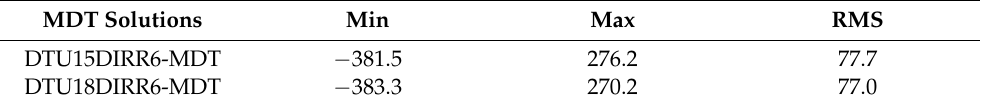
Figure 7. The MDTs of the ( a ) DTU15DIRR6-MDT and ( b ) DTU18DIRR6-MDT, and the corresponding differences between them and the reference MDT ( c , d ). Table 7. Statistics of the differences between the estimated MDTs and the reference MDT (Units: